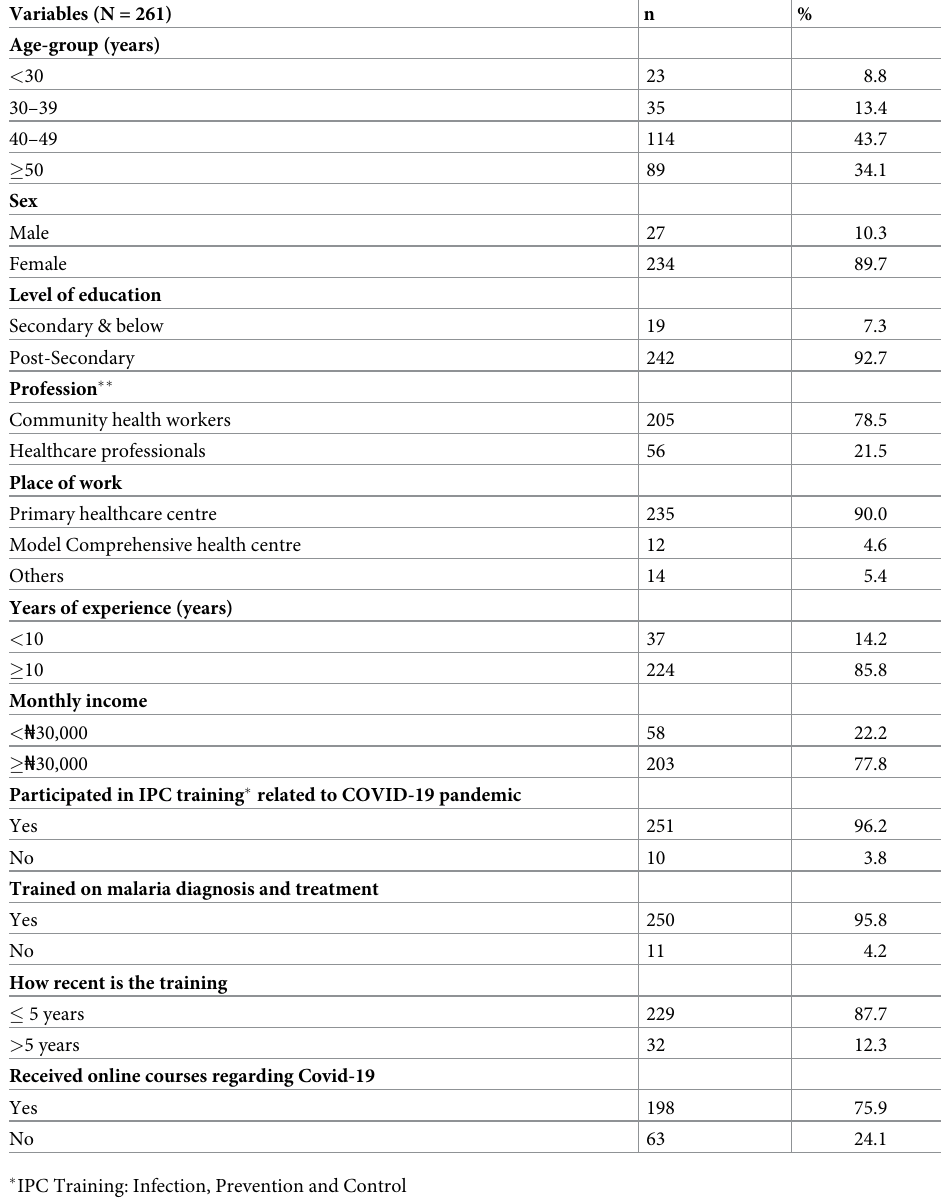
Table 1. Socio-demographic characteristics of primary health care